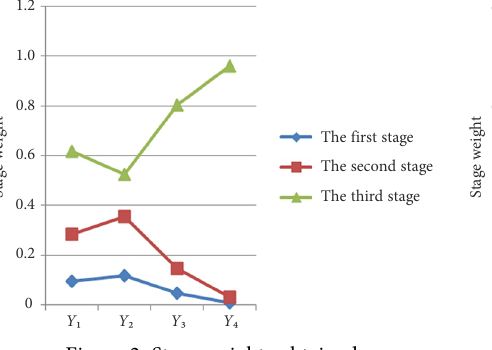
Figure 3. Stage weights obtained by the proposed